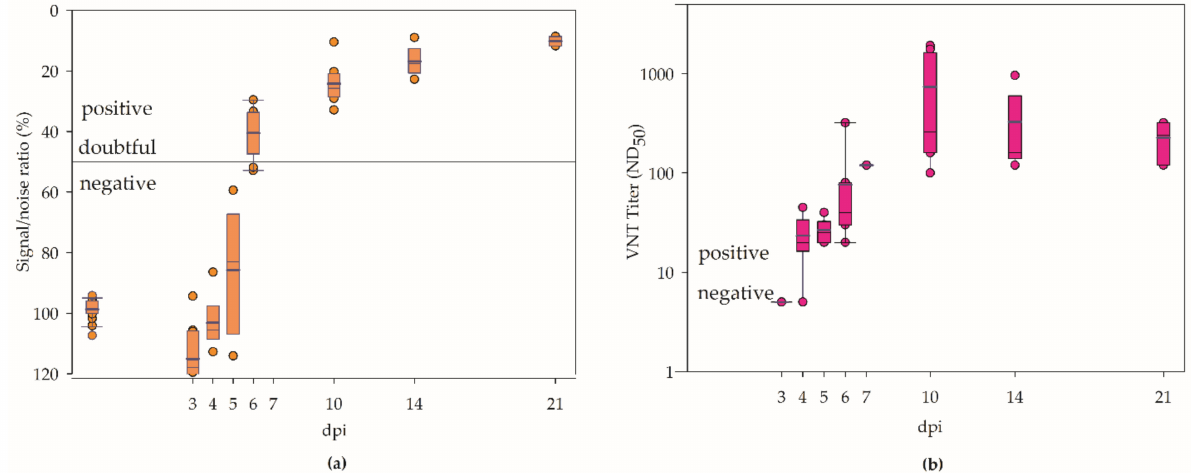
Figure 5. Seroconversion of all WNV-inoculated geese. Data are presented in a box-and-whisker plot, with the box including 50% of the values for each group and the dark-blue line in the middle of each group representing the median value. ( a ) Antibodies examined by a conventional competition IgG ELISA dyed in orange. ( b ) Antibodies examined by VNT dyed in